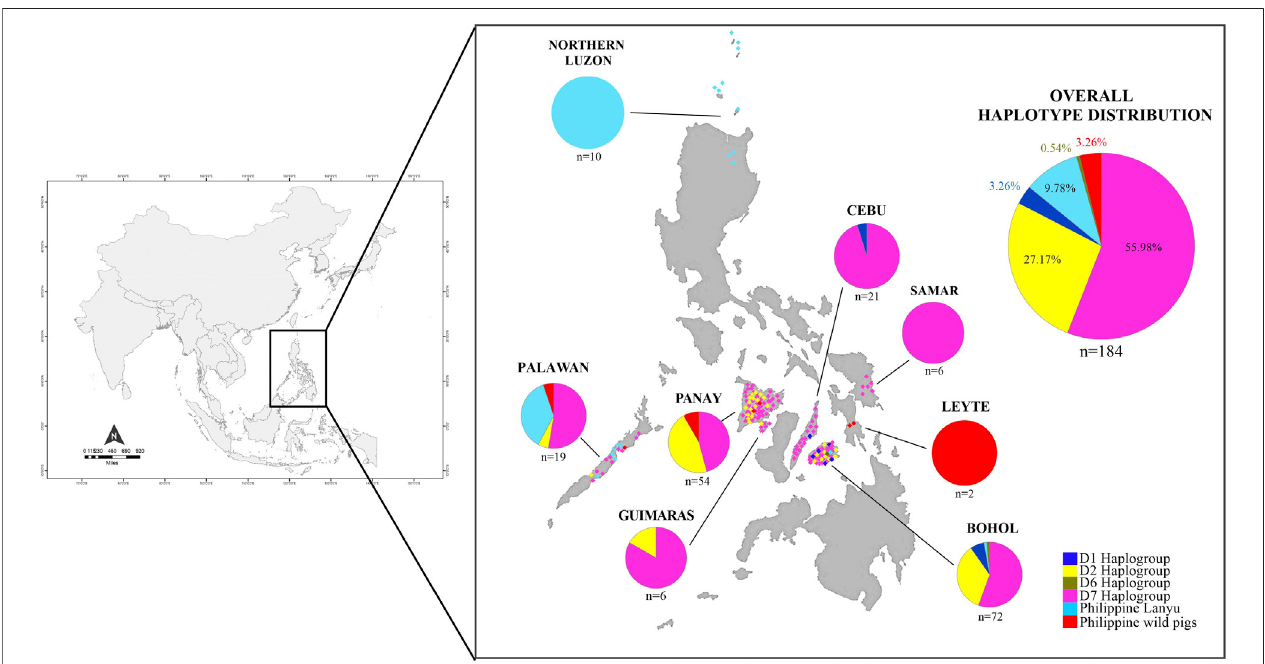
FIGURE 1 | Distribution map of Philippine pigs and ancestry coef fi cients visualizing the geographic distribution of the different haplogroups found in this study.